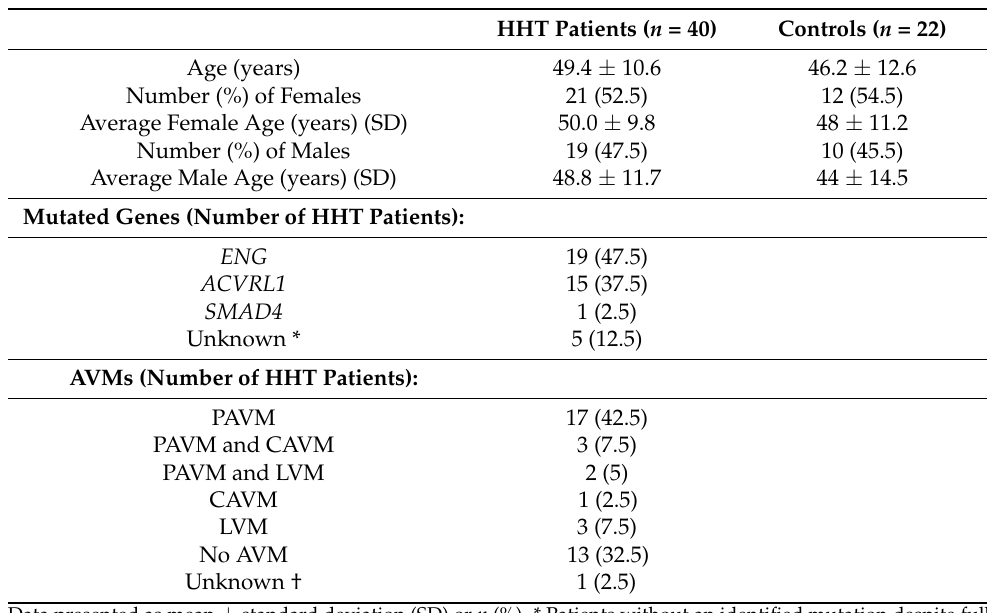
Table 1. Summary of demographics and clinical